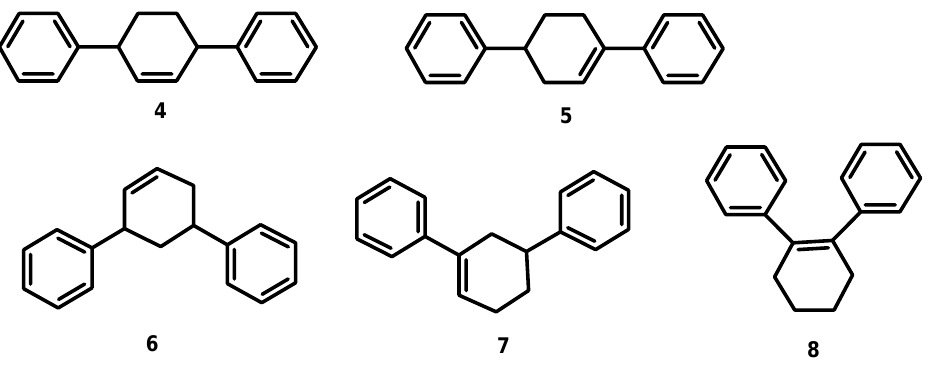
Figure 2. Diarylated products formed in the Heck reaction of cyclohexene with